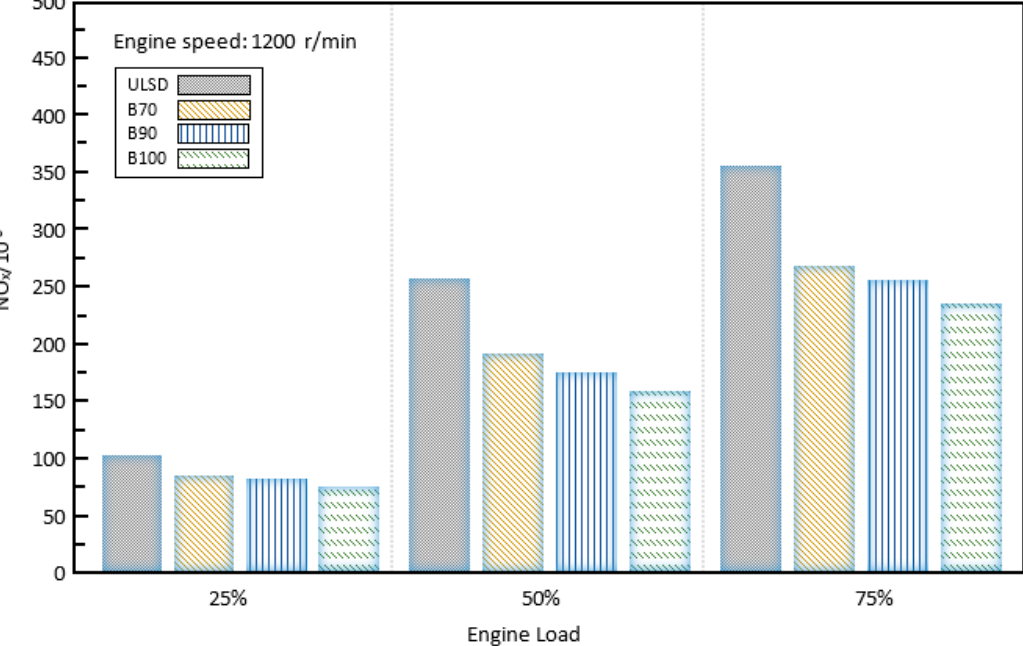
Figure 10 . Tested fuels’ influence on the exhaust gas temperature at 1200 rpm .